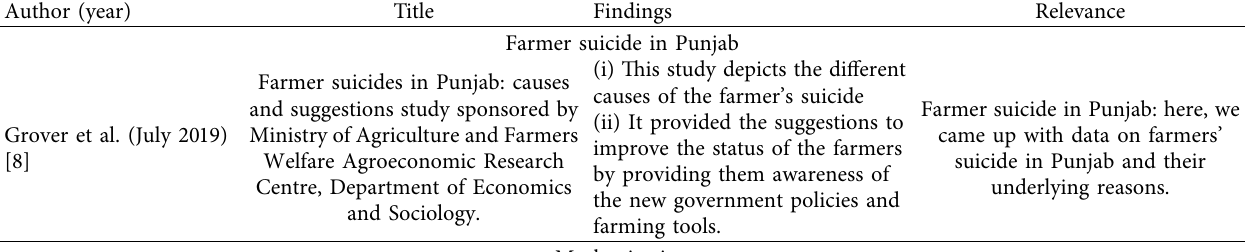
Table 1: Literature review for renting and hiring of equipment using machine learning algorithm with recommendation system and supply demand based